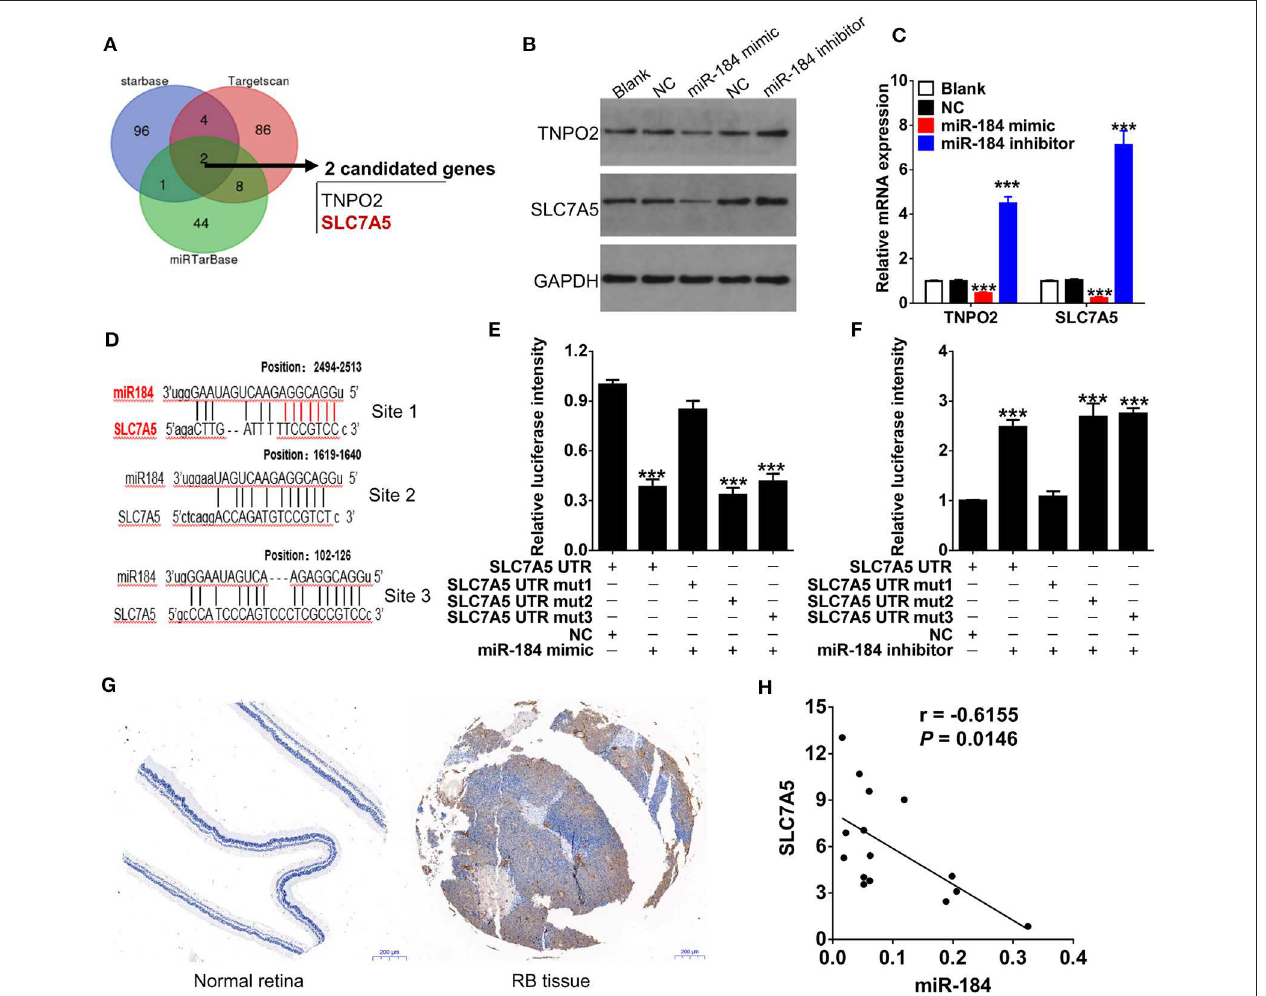
FIGURE 4 | SLC7A5 is a direct target of miR-184. (A) Bioinformatics algorithms (TargetScan, Starbase, and miRTarBase) predicted the target of miR-184. Venn diagram found that TNPO2 and SLC7A5 are two shared targets of miR-184. The expressions of SLC7A5 and TNPO2 in Y79 cells with different transfection were detected by Western blot (B) and qRT-PCR (C) . (D) The three putative miR-184 binding sites in 3 ′ UTR of SLC7A5. (E) The wild-type (WT) or mutant (Mut) reporter constructs was cotransfected with negative control or miR-184 mimic into Y79 cells, and the dual luciferase activity was determined at 48h after transfection. (F) The WT or Mut reporter constructs were cotransfected with negative control or miR-184 inhibitor into Y79 cells, and the dual luciferase activity was determined at 48h after transfection. (G) SLC7A5 expression in normal retina and Rb tissues was detected by immunohistochemistry. (H) Spearman correlation analysis showed that SLC7A5 mRNA level is negatively associated with miR-184 in 15 RB tissues. Data were presented as mean ± SD of three independent experiments. *** P < 0.0001 vs. negative control